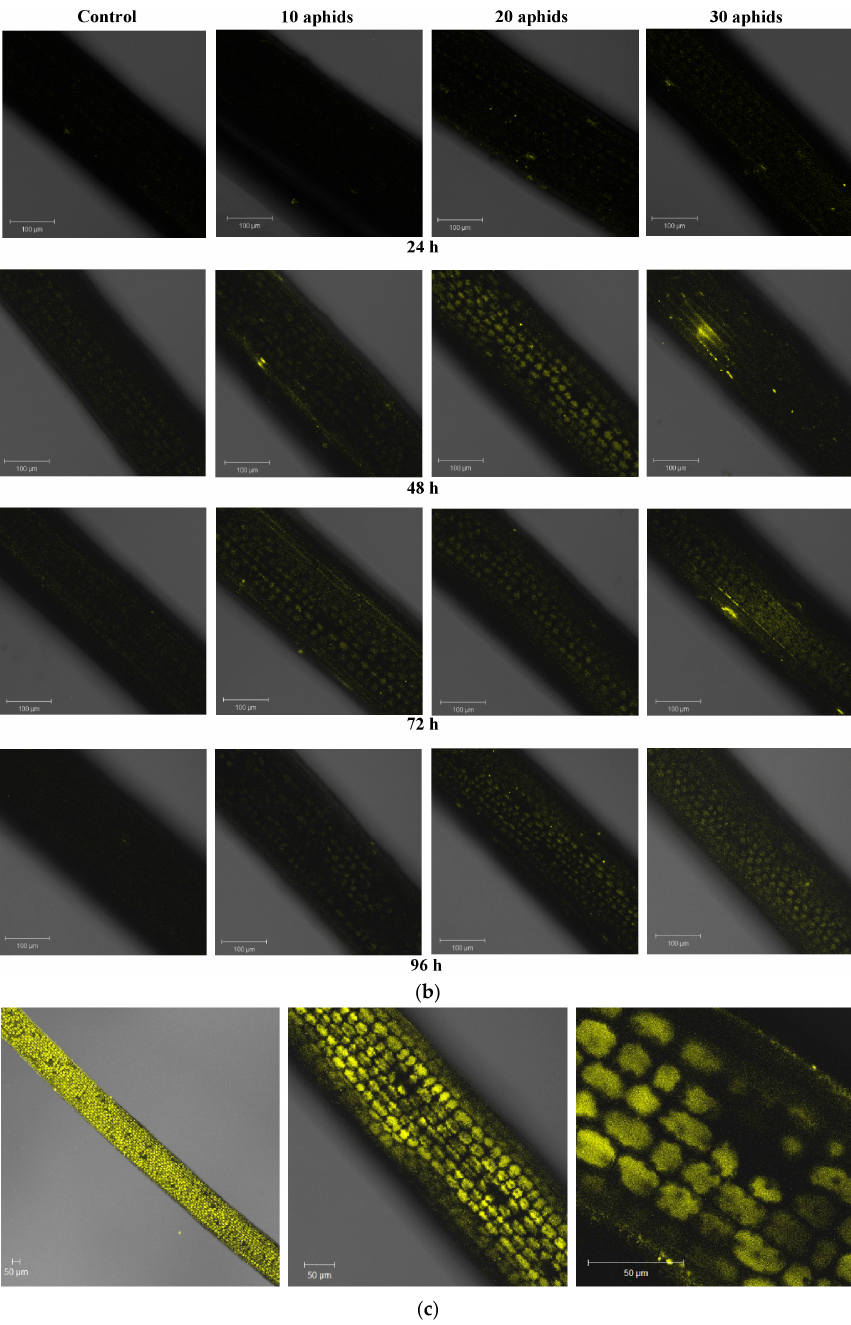
Figure 2. Relative generation and cytochemical localisation of superoxide anion radical in leaves of one- ( a ) and two-month-old plants ( b ) of Asparagus officinalis L. cv. Argenteuil infested by Brachycorynella asparagi (Mordv.) at a varied population size (10, 20, and 30 aphids per plant); and 96-h leaves of Asparagus officinalis one-month-old plants infested by 30 aphids B. asparagi per plant ( c ). Yellow fluorescence originating from DHE (dihydroethidium) was observed under a Zeiss LSM 510 confocal microscope (objective magnification of 20× for a , b and 5×, 20× and 63×, respectively, for c ). Scale bar 100 µm ( a , b ) and 50 µm ( c ).